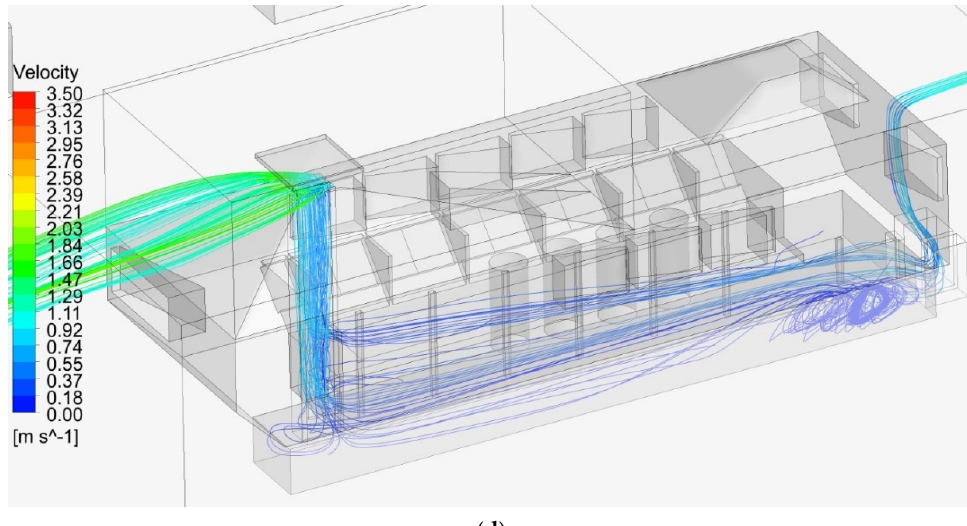
Figure 10. Airflow patterns in the cellar and the industry hall in the case of updraft (UD) PACS (colors and vectors by air velocity [m/s])—( a ) cross section of the airflow through the UD tower under NE wind direction, ( b ) cross section through the inlet gates behind the building under NE wind direction with counter wise vortices, which are responsible for the negative ACH amplitudes, ( c ) longitudinal section of the airflow in and around the building under NW wind direction; ( d ) 3D streamlines of the airflow under NW wind direction.